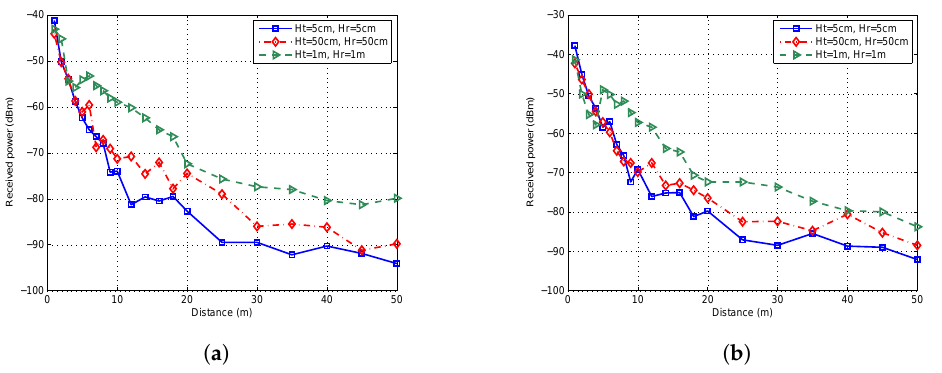
Figure 2. Received power with different antenna heights: ( a ) flat concrete road; and ( b ) flat grass.